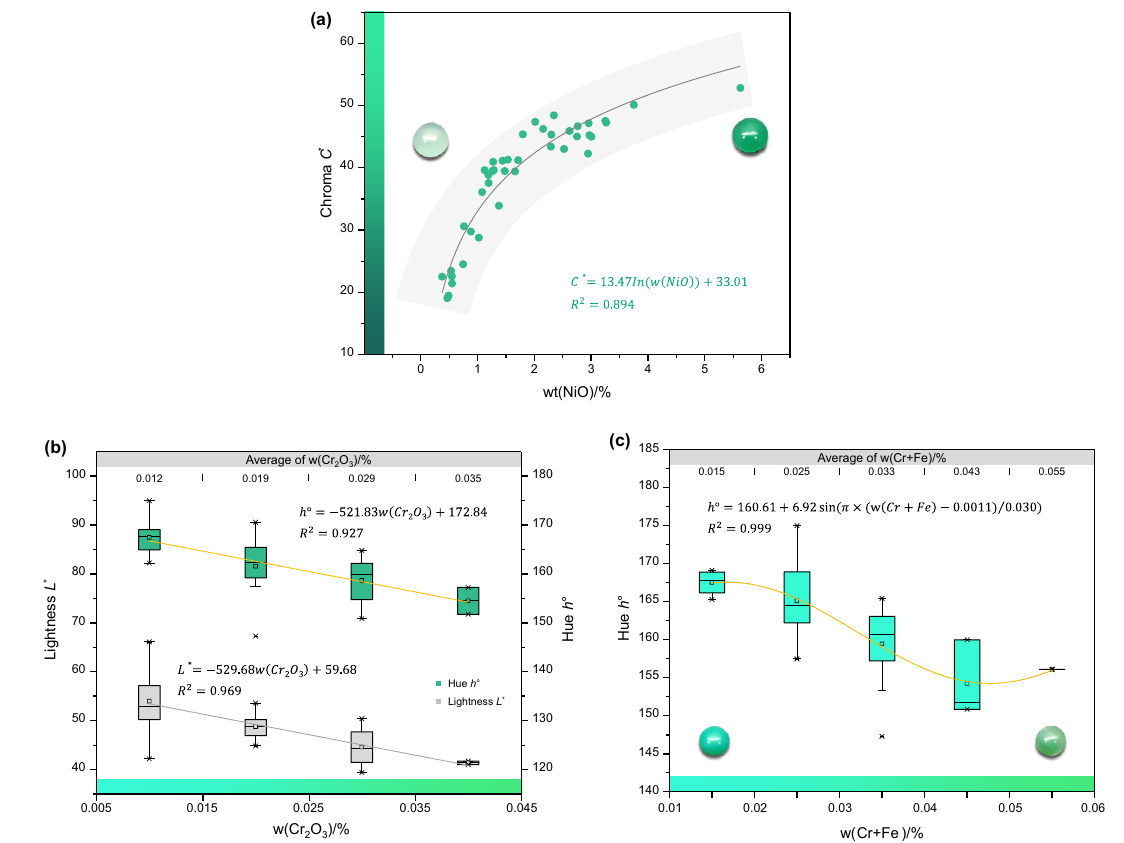
Figure 3. Relationship between colour parameters and transition-metal elements. ( a ) There is a highly positive correlation between Ni content and chroma. ( b ) With increasing Cr content, the lightness and hue angle exhibit downward trends. ( c ) Both Cr and Fe affect the hue angle; the higher the content of Cr and Fe, the smaller the hue d-d transitions 3 A 2g (F) → 3 T 1g (P) and 3 A 2g (F) → 3 T 1g (F). The shoulders near 450 and 740 nm correspond to spin- forbidden d-d transitions 3 A 2g (F) → 1 T 2g (D) and 3 A 2g (F) → 1 E g (D) 34,35 . The transmission window that occurs between the two main bands of chrysoprase centred at 380 and 660 nm is responsible for the hue of the samples (Fig. 4b). Upon changing the wavelength corresponding to the lowest absorption value in the blue–green region of the spectrum, the hue angle of chrysoprase also changes. When the wavelength decreases, the hue angle increases and the hue shifts to bluish green; when the wavelength increases, the hue angle decreases and the hue shifts to yellowish green. The presence of Cr 3+ and Fe 3+ in chrysoprase results in its yellowish hue, this being because the absorptions related to the spin-allowed d-d transitions 4 A 2g (F) → 4 T 1g (F), 4 T 1g (P) caused by Cr 3+ and the charge transfer O 2− → Fe 3+ overlap in the short-wave part of the spectrum. Consequently, the wavelength corresponding to the lowest absorption value in the blue–green region of the spectrum shifts to the short-wave direction with an increasing sum of Cr and Fe contents. As shown by Fig. 4c, the colour change exhibits decreasing hue angle, and the hue tends to yellowish green, which is coincident with the former conclusion that the sum of Cr and Fe contents is related negatively to the hue angle. Sachanbiński et al. 5 reasoned that λ-dependent light scattering on micro defects in the chalcedony matrix (e.g. silica globules, nano- and micrometre-size mineral inclusions and gas–liquid inclusions) would lead to a decrease in the absorption within the short-wave part of the spectrum so that the wavelength corresponding to the lowest absorption value in the blue–green region of the spectrum shifted to the short-wave direction. The colour change was characterized by increasing hue angle, and the hue tended to bluish green. There is a highly positive correlation between the area of the 660-nm absorption peak and the colour of chrysoprase, and the Pearson correlation coefficient r is 0.889. Figure 4d shows directly that the larger the area of 660-nm absorption peak, the greater the chroma of chrysoprase. The absorption at 660 nm is caused by the d-d electron transition of Ni 2+ . As shown in Fig. 4e, increasing Ni content leads to increased area of the absorption peak at 660 nm, so the chrysoprase colour will also change, as shown by the increasing chroma. This is consistent with the conclusion that there is high positive correlation between w(NiO) and the chroma C * of chrysoprase as obtained by EDXRF analysis. The lightness of chrysoprase is negatively correlated with the sum of absorption peaks at 380 and 660 nm. As shown in Fig. 4f, the greater the sum of absorption peaks of 380 and 660 nm is, the darker the colour of chrysoprase is. This is because in the visible light band of 400 nm-700 nm, the more energy absorbed by 380 and